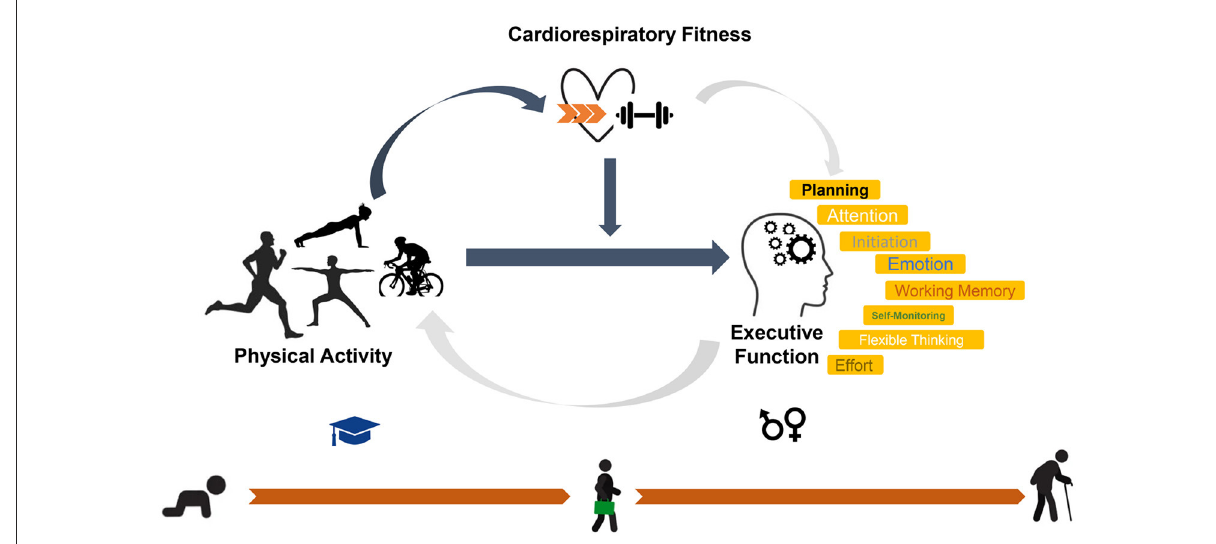
FIGURE1 Theoretical model of a lifelong interrelationship between physical activity, cardiorespiratory fitness, and executive function. The working model hypothesized that different physical activity intensities may slow cognitive aging in the subdomain of executive function, from middle age through late life. Sufficient physical activity intensity may preserve executive functioning in middle age through its effect on cardiorespiratory fitness or other neuroprotective pathways. Moreover, we theorized that cardiorespiratory fitness may moderate the association between specific physical activity intensity patterns and executive function. We will investigate thoroughly the interrelationship between physical activity intensities, cardiorespiratory fitness, and executive function by following the pathways pointed by dark arrows in this figure. The gray arrows indicate (1) possible pathways from cardiorespiratory fitness to executive function, such as cerebral perfusion and cardiovascular health, (2) reverse pathways from executive function to physical activity intensities, such as making exercise